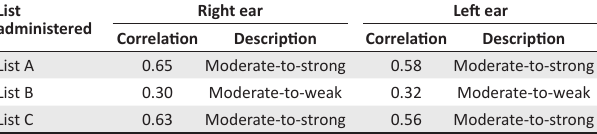
correlation per list.